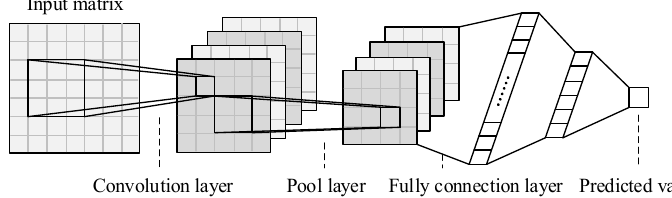
Figure 1. CNN structure diagram.